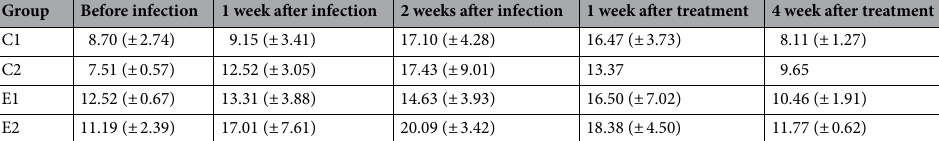
Table 4. Changes of WBC count. The changes are depicted as mean ± standard deviation (SD).